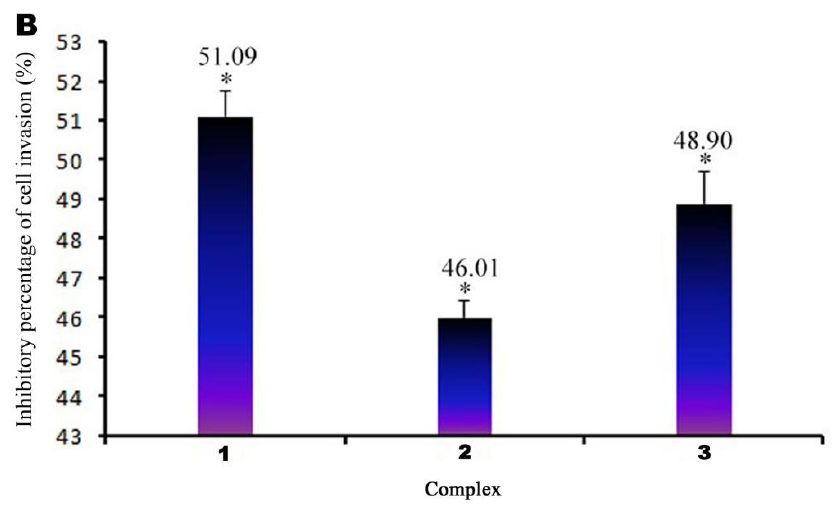
Figure 4. ( A ) Microscope images of invading SGC-7901 cells (control, a) that migrated through the Matrigel after exposure to 1 (4.0 µM) (b), 2 (15.0 µM) (c), or 3 (15.0 µM) (d) for 24 h. ( B ) Percentage of inhibited invasion of SGC-7901 cells induced by exposure to 1 , 2 , or 3 for 24 h. * p < 0.05 represents significant differences, compared with control.